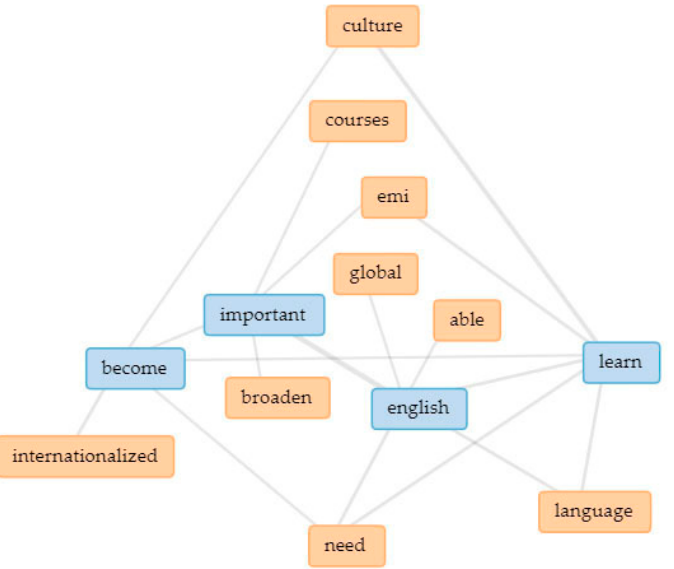
Figure 4. Interrelationships and extended links among the perceived EMI objectives.